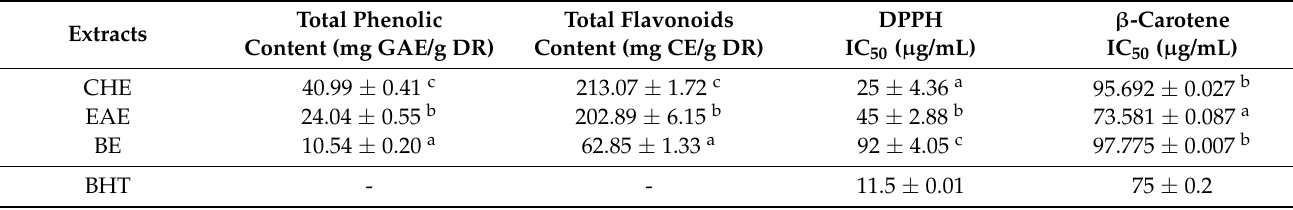
Table 1. Total phenolic and flavonoid contents expressed as gallic acid and catechin equivalents, in mg/g dry sample, respectively, DPPH radical-scavenging activity and β -carotene bleaching